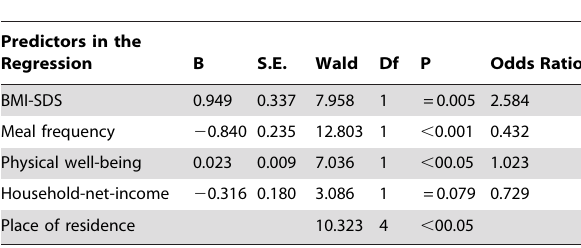
Table 3. Factors associated with program